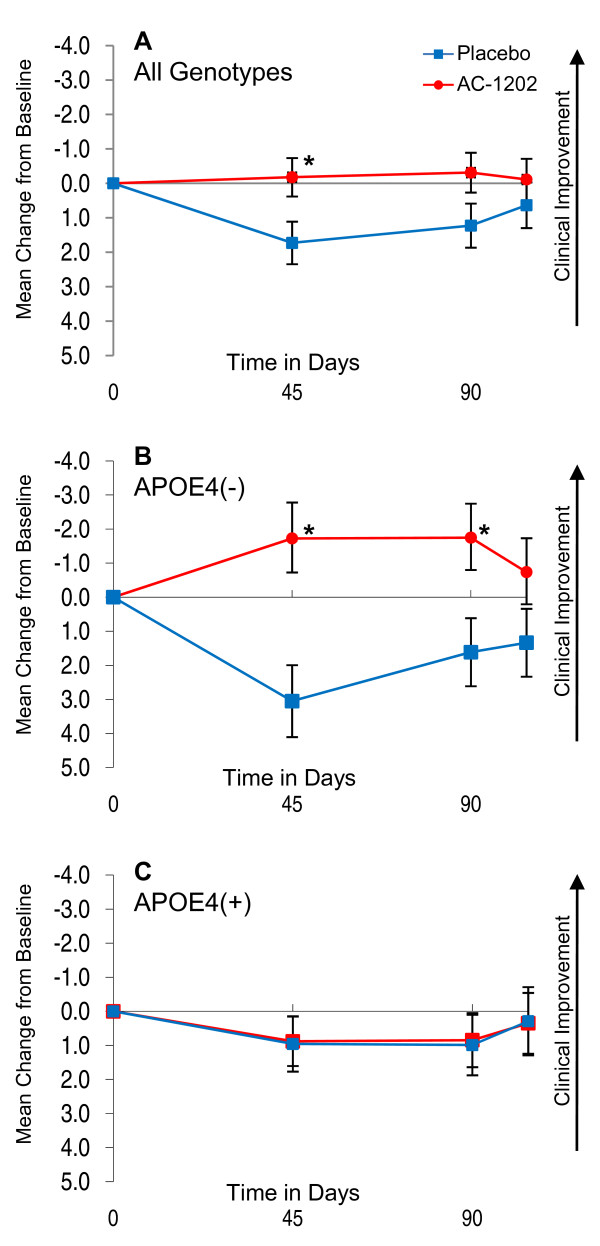
Mean change in ADAS-Cog scores from Baseline in the ITT population w/LOCF and stratified by APOE4 carriage status. Y axis is change from Baseline. X axis is time in days. Red circles and lines represent subjects taking AC-1202. Blue squares and lines represent subjects taking Placebo. Error bars represent standard error of the mean. Asterisks (*) indicate a significant (p-value < 0.05) difference in mean change from Baseline between AC-1202 and Placebo. A) Intention to treat subjects (N = 77AC, N = 63PL) administered AC-1202 demonstrate a significant difference from Placebo at Day 45. B) Genotyped subjects lacking the APOE4 allele (APOE4(-)) (N = 29AC, N = 26PL) and administered AC-1202 demonstrate a significant difference from Placebo at Days 45 and 90. C) Genotyped subjects carrying the APOE4 allele (APOE4(+)) (N = 38AC, N = 31PL) do not differ from Placebo at any time point. For confidence intervals and p-values see Table 5.